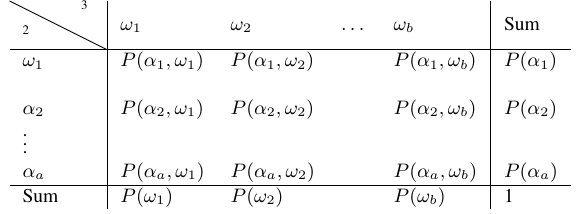
Table 1. Computation of site-wise conditional probability matrix.